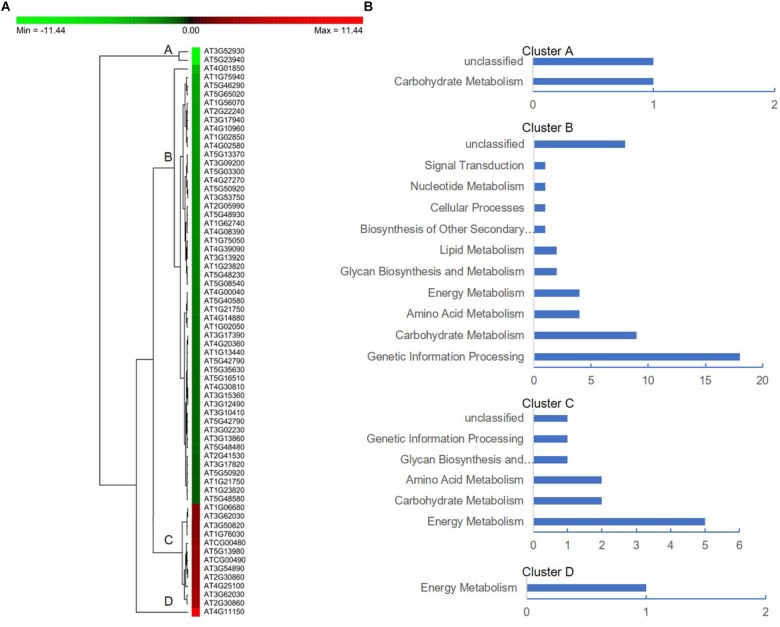
Protein expression profiles of the DEPs between Shaan2A and Shaan2B. (A) Hierarchical clustering of proteins showing quantitative changes in expression. (B) Protein functional classification of four clusters.